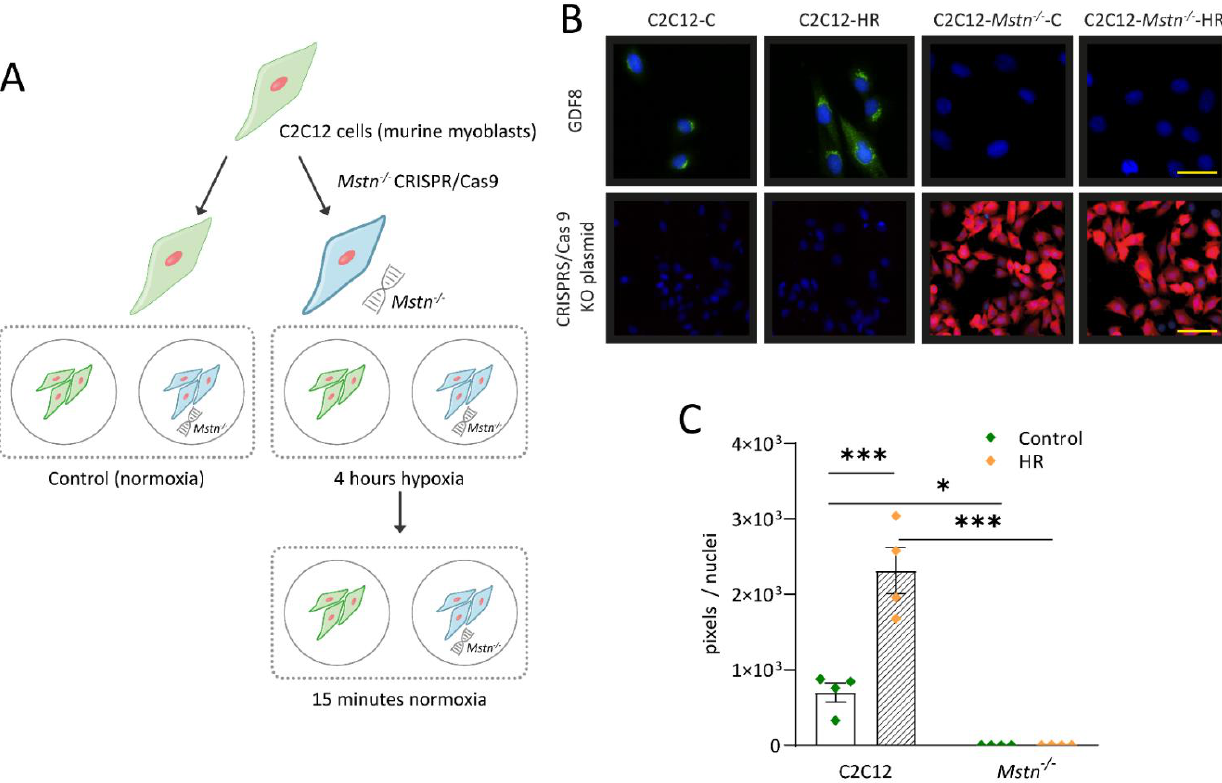
Figure 1. Schematic representation of the in vitro workflow and proof of successful gene editing via CRISPR/Cas9. ( A ) C2C12 cell genome was edited using CRISPR/Cas9 technology to induce Mstn knockout. C2C12 and C2C12- Mstn −/− cells were then exposed to 4 h of hypoxia, followed by 15 min of reoxygenation (HR). Control C2C12 cells were incubated at normoxic conditions for the same time. ( B ) The upper panel illustrates myostatin expression levels ( green ). The lower panel depicts a visualization of the CRISPR/Cas9 KO plasmid (red) . Cell nuclei were counterstained with DAPI. ( C ) Quantification of myostatin expression levels. C, control cells incubated under normoxia. HR, cells incubated under hypoxic conditions for 4 h followed by normoxia for 15 min. For each graph, four independent experiments per group were conducted. Scale bar = 25 μm (upper panel), 50 μm (lower panel). Results are shown as means ± SEM. p -value: * < 0.05, *** < 0.001; ANOVA followed by a multiple test comparison via Tukey’s post-hoc test (homoscedasticity) or Brown–Forsythe and Welch ANOVA followed by Dunnett’s T3 post-hoc test (heteroscedasticity).